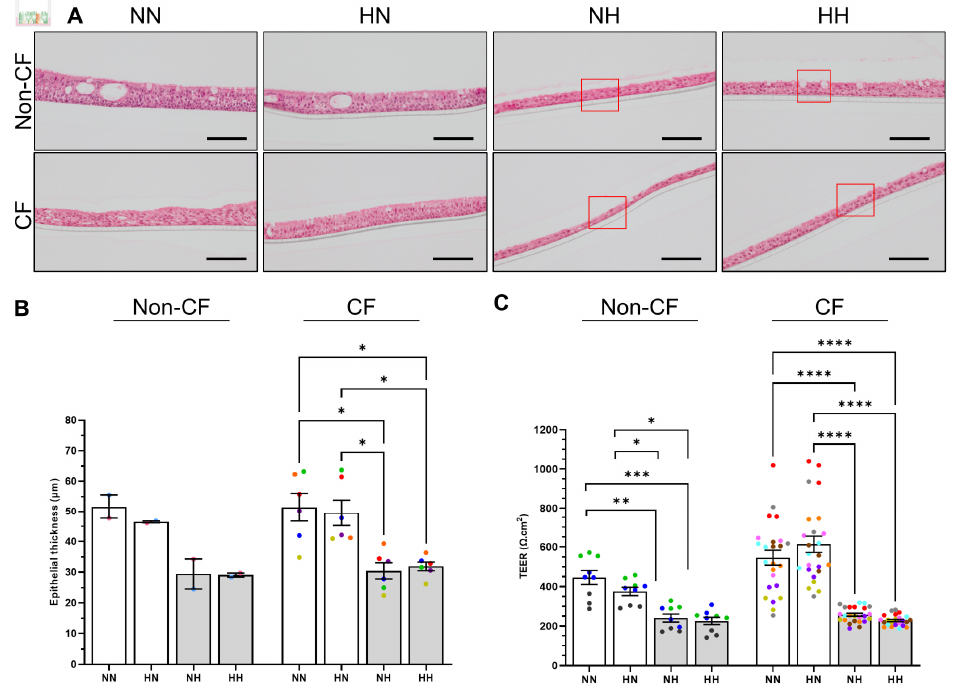
Figure 4. Effect of chronic hypoxia on the structure and barrier integrity of differentiated human nasal epithelial cells (hNECs). ( A ) Representative H&E stain of primary hNECS differentiated at ALI in normoxia (NN and HN) and chronic hypoxia (NH and HH) for 21–25 days. Refer to Figure S3 for complete set. Red rectangle shows squamous cells or cells transitioning towards squamous morphology. 40 × /0.8 objective. Scale bars = 100 µ m. ( B ) ALI culture thickness measured from five sections per membrane (>20 random fi elds of view) per condition. Each colored circle represents an individual participant. ( C ) Transepithelial electrical resistance (TEER) of ALI cultures. Each individual participant’s data is presented with a di ff erent color. Three independent transwells were analyzed per participant. Data are presented as bar plots with mean ± standard error of the mean (SEM). One-way ANOVA was used to determine statistical signi fi cance. * p < 0.05, ** p < 0.01, *** p < 0.001, and **** p < 0.0001.